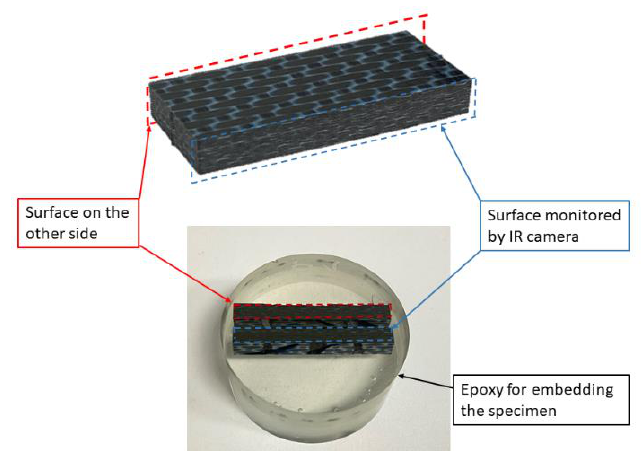
Figure 4. An overview of a typical specimen embedded inside polymer for microscopy .